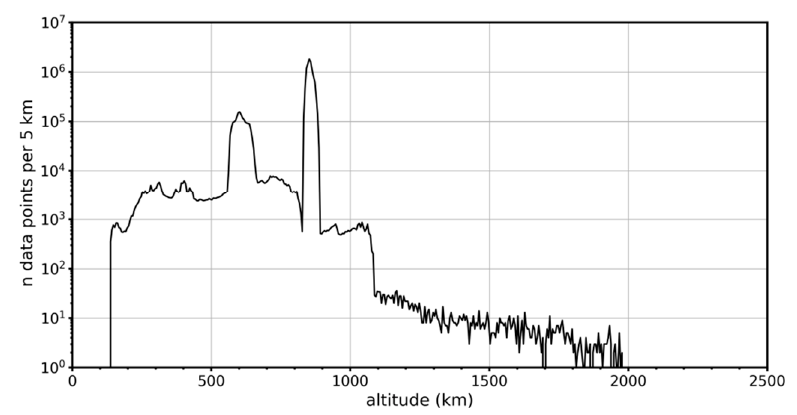
Figure 3. Histogram (number of data points in 5 km bins vs. altitude) of the ion temperature data in our database.